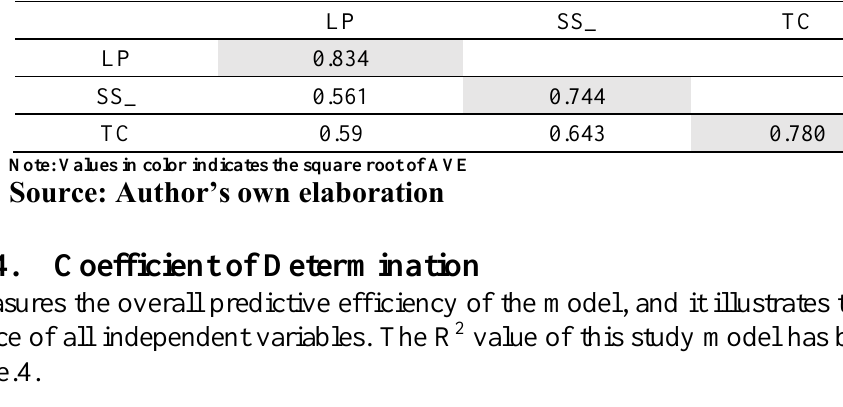
Table.3. Discriminant Validity